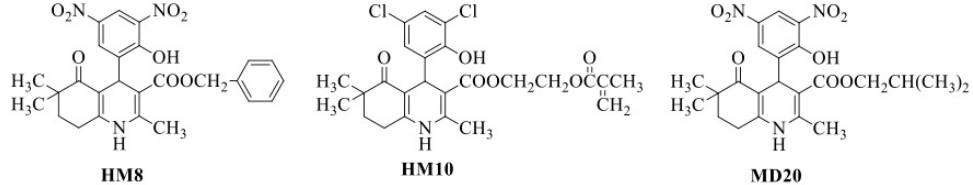
Figure 1. Chemical structures of HM8, HM10 and MD20.